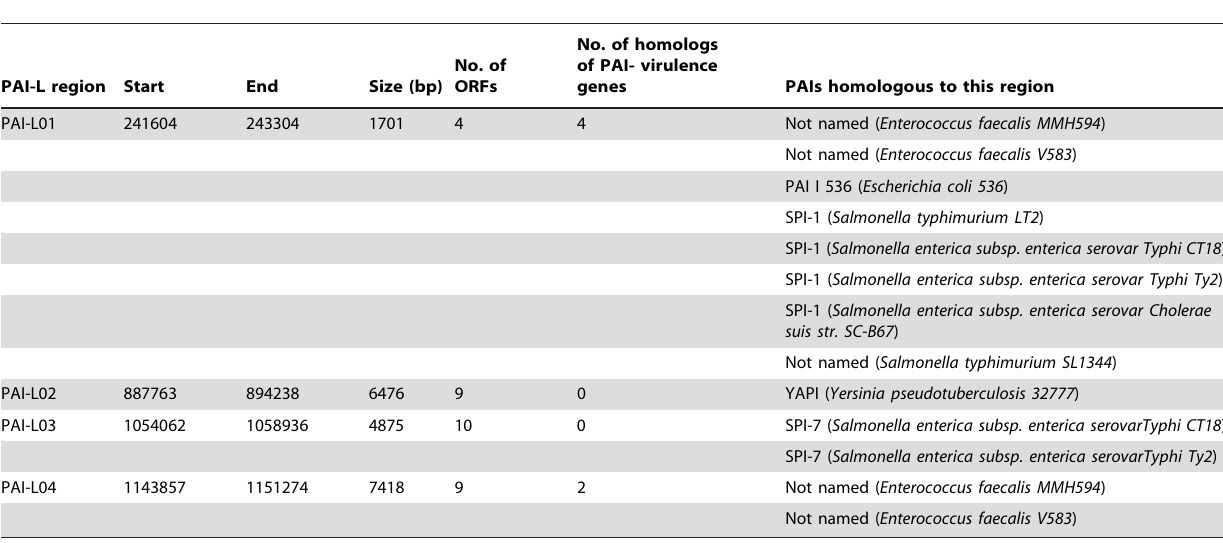
Table 5. Annotation of PAI-like regions in H. parasuis strain ZJ0906.